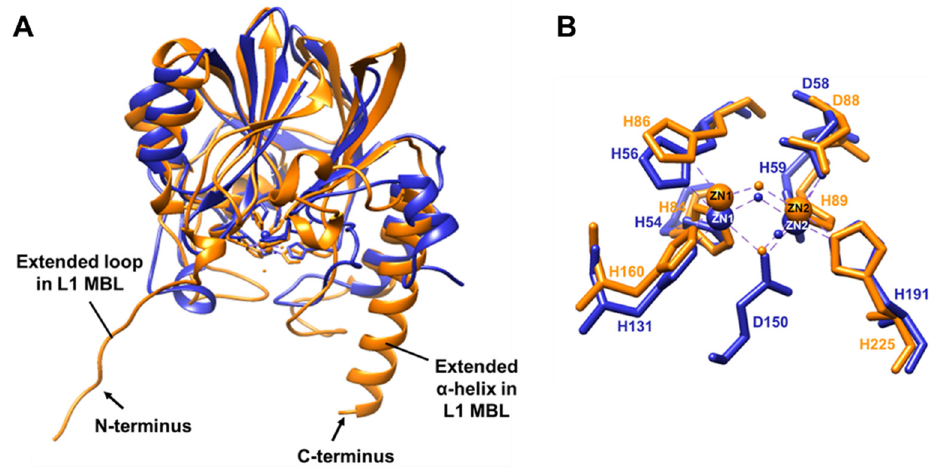
Figure 6. Superimposition of the ( A ) overall protein structure and ( B ) metal coordinating residues of BLEG-1 (blue) with L1 MBL (PDB ID: 1SML, chain A) (orange).